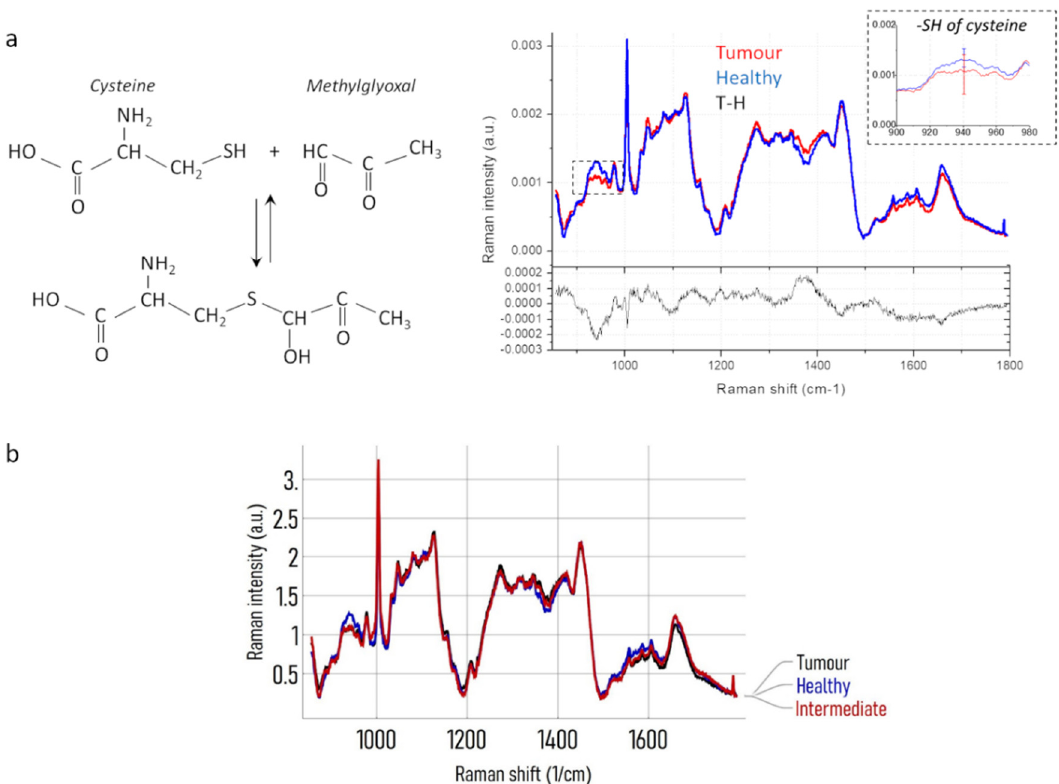
Figure 6. Raman Spectra of Secretome produced by Healthy and Cancer patients BDCs. ( a ) Scheme of the reaction between cysteine and methylglyoxal (left side); comparison between the average Raman spectra of cancer patients (Tumor) and healthy subjects (Healthy) and, in the bottom, their difference spectrum (right side). ( b ) Average Raman spectrum of intermediate cases, Healthy H and Tumor T T spectra. Table 1. Principal Raman band assignments for the analyzed spectra of healthy, cancer, and intermediate subjects.